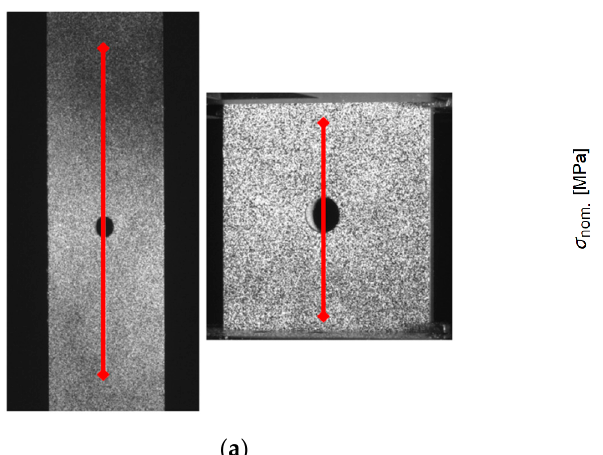
( b ) Figure 3. Nominal stress vs. global strain of samples subjected to monotonic loading until failure. ( a ) OHT, ( b ) OHC. The cases for OHT are shown in Figure 3a. The coupons with layup [0/90] 5s and [+45/0/ − 45/90] 3s show quasilinear behavior up to sudden failure at about 220 MPa. The coupon with layup [+45/ − 45] 5s initially shows linear behavior. This, however, turns non- linear at 1% strain. A failure strain of about 12–15% is observed with a failure load of about 150 MPa. These failure strains are significantly higher than for the other specimens be- cause the +45/ − 45 plies are primarily loaded in shear. This loading type is matrix-domi- nated and illustrates the large deformation capability of the PA6 matrix. Remarkable is that the OHT strength of the QI laminate is higher than the OHT strength of the coupon with layup [0/90] 5s . This is caused by the high OHT strength of the +45/ − 45 plies, which contribute significantly to the strength of the QI laminate.